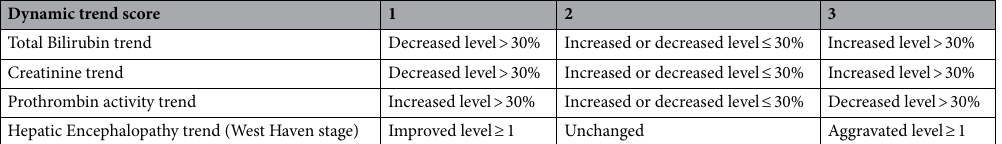
Table 2. Dynamic trend scores based on the changing trends of total bilirubin, creatinine, prothrombin activity, and hepatic encephalopathy stage.